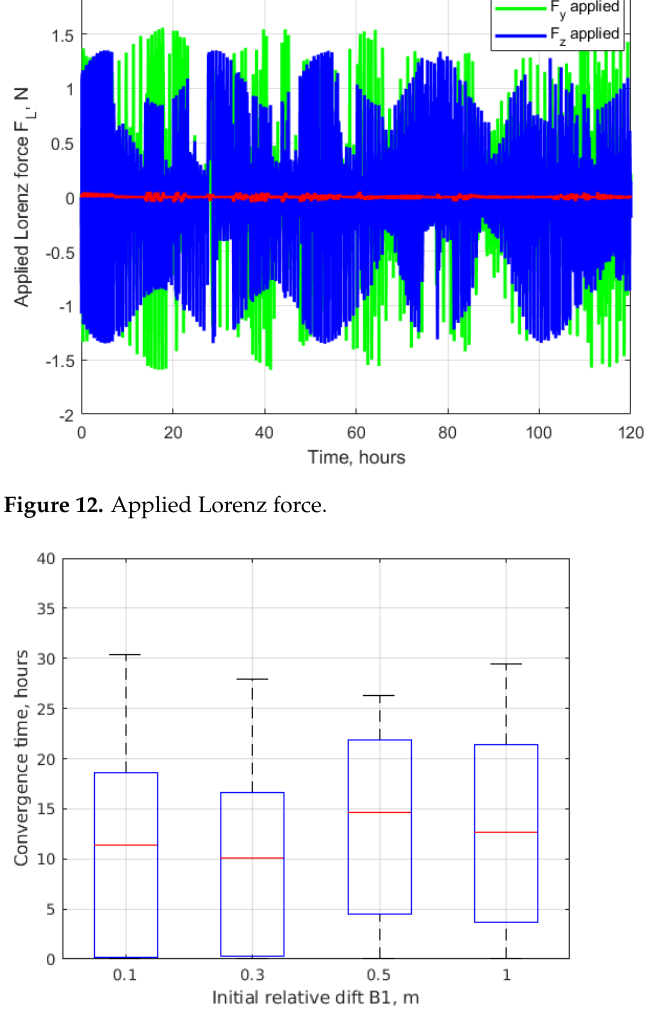
Figure 13. Convergence time depending on initial drift